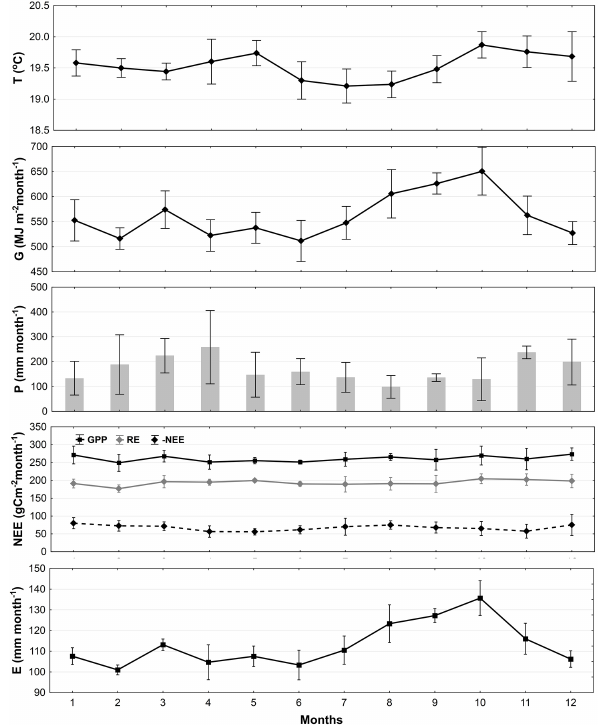
Figure 2. Mean intra-annual values of air temperature ( T ), global solar radiation ( G ), precipitation ( P ), NEE, GPP, RE and ET for the tropical rain forest in Bariri. Vertical whiskers indicate standard deviations